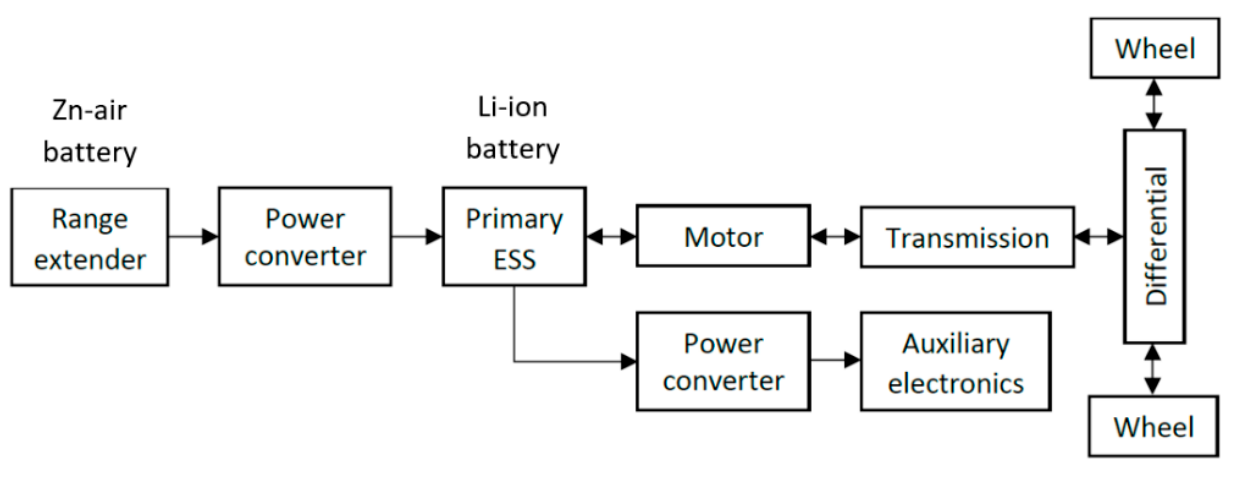
Figure 6. Powertrain architecture with zinc-air battery as a range extender. Adapted from [64].